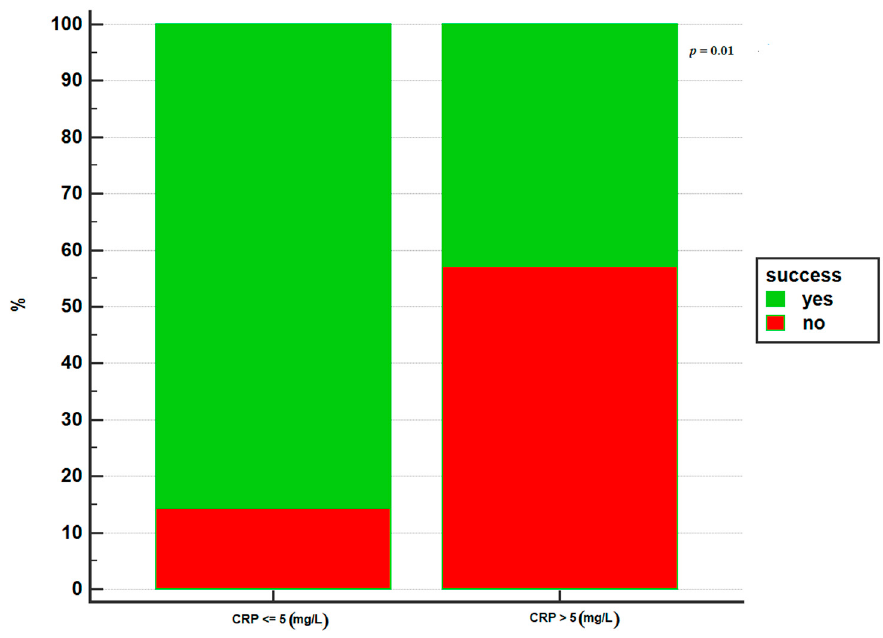
Figure 1. CRP value at the switch and success of the switch.